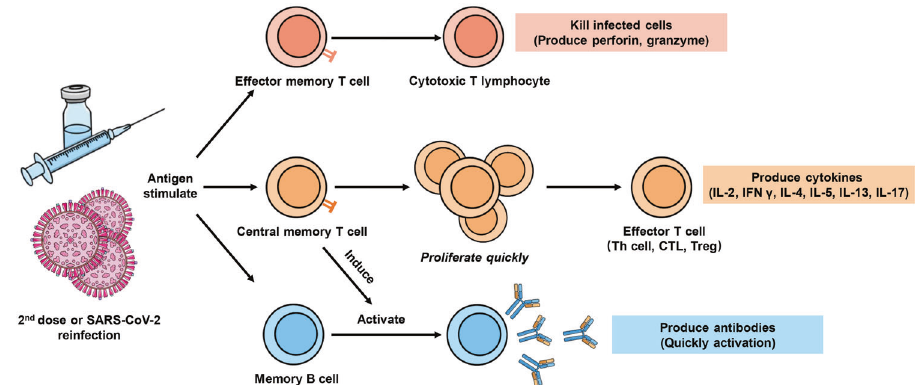
Fig. 4 Vaccine-induced memory cell response. In the Th1 and GC B-cell processes, antigen-speci fi c memory T cells and memory B cells are usually formed. Unlike initial T-cell activation, the activation of memory T cells no longer depends on antigen-presenting cells and can induce